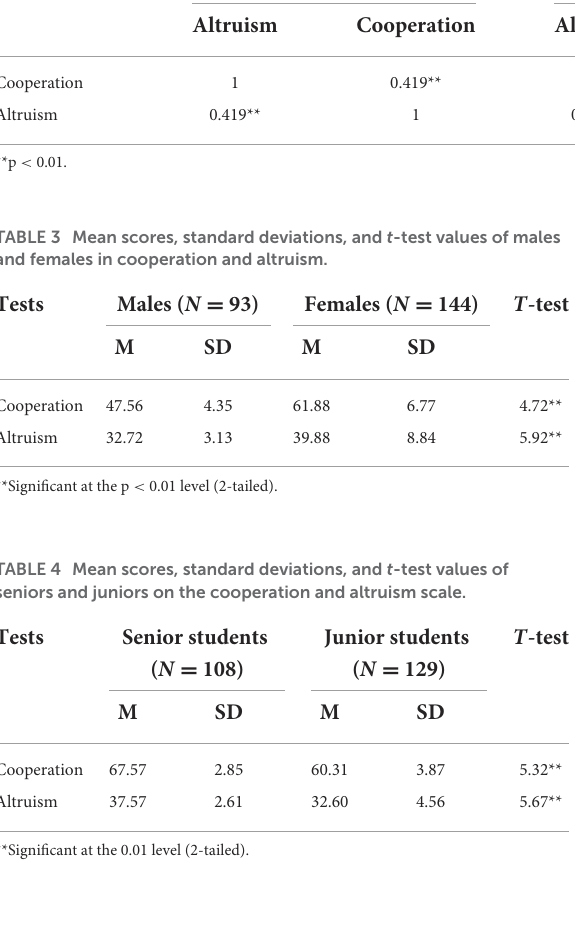
TABLE 2 Pearson correlation coefficients between cooperation and altruism among gifted University students. Correlations